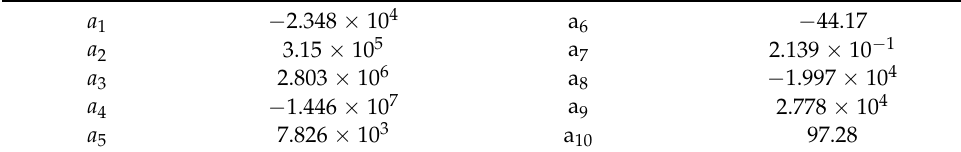
Table 1. Coefficients used in Equation